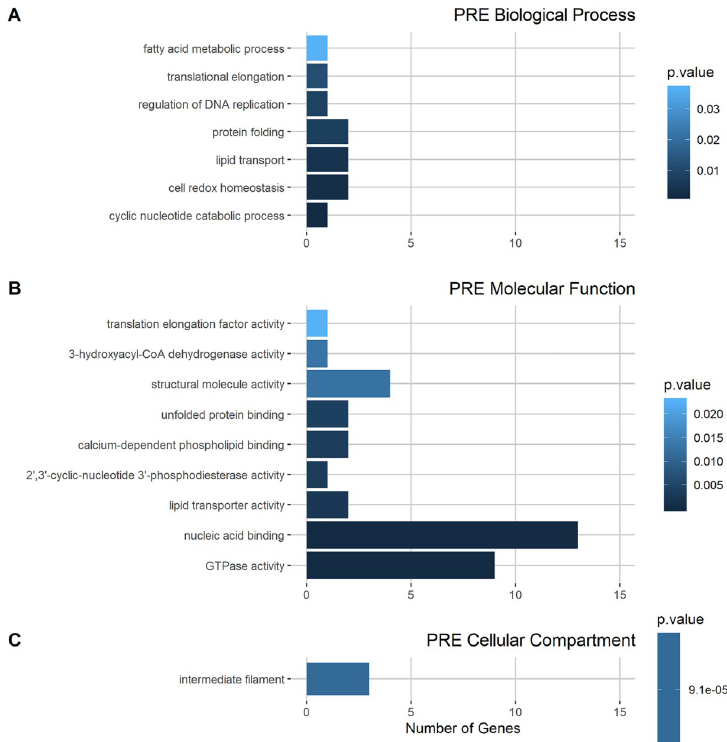
Fig 5. GO term enrichment of upregulated proteins in prehatching (PRE). A) Biological process GO terms, B) molecular function GO terms, and C) cellular compartment GO terms. The color of each bar corresponds to the p- value of the Fisher test (see legend of each plot). The output of the analysis and the genes associated with each GO term are shown in S3